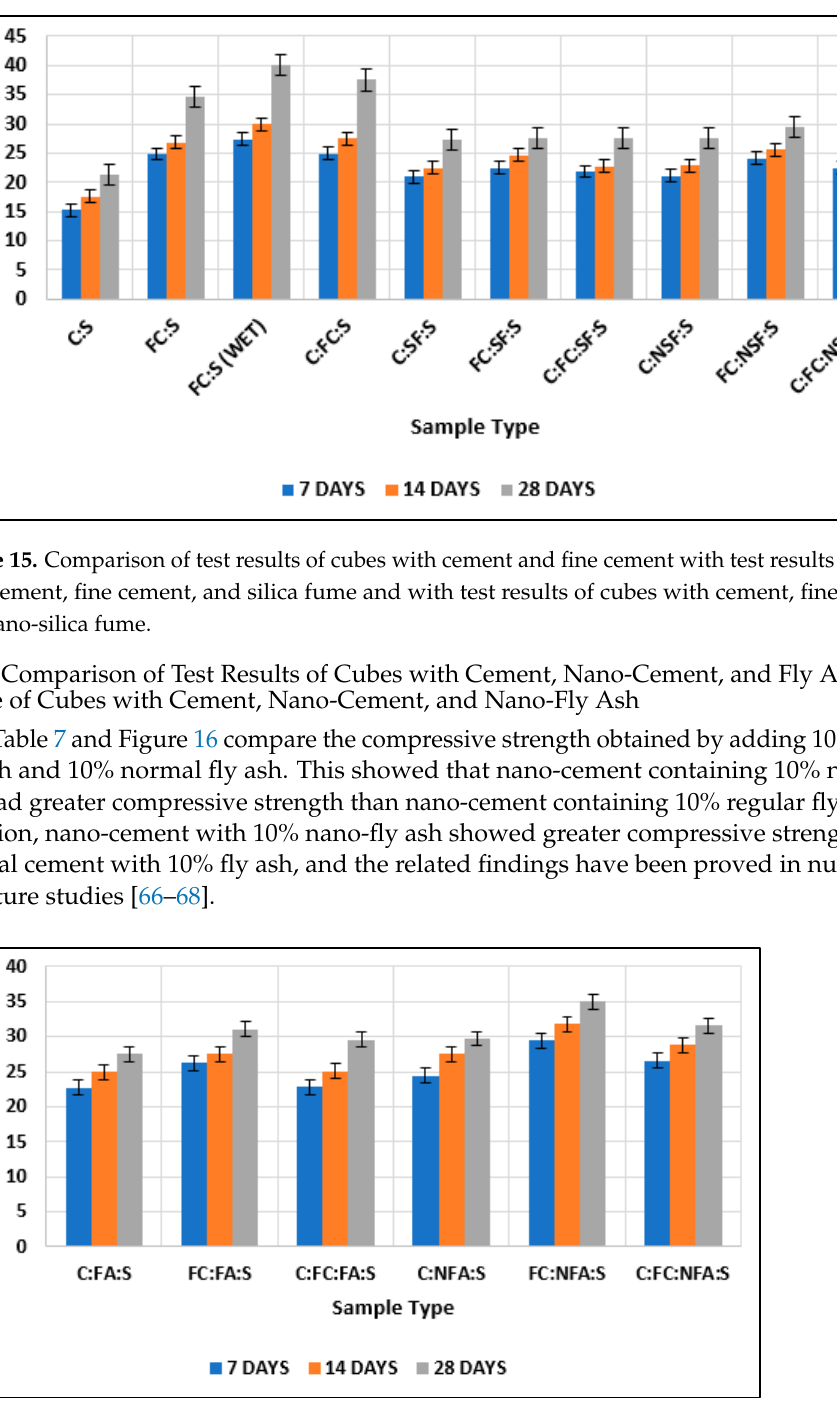
Figure 16. Comparison of test results of cubes with cement, fine cement, and fly ash with test results of cubes with cement, fine cement, and nano-fly ash. of cubes with cement, fine cement, and nano-fly